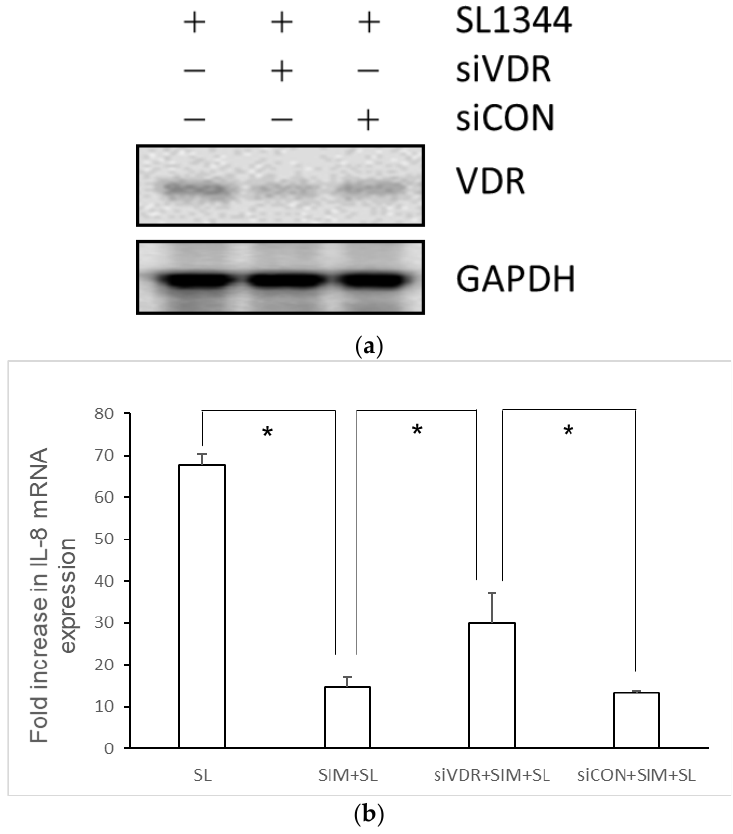
Figure 4. Involvement of vitamin D receptor (VDR) in simvastatin-mediated downregulation of IL-8 mRNA expression in Salmonella -infected SW480 cells. SW480 cells were transfected with control siRNA or VDR siRNA (siCON = non-target control siRNA; siVDR = siRNA against VDR) for 48 h. Transfected SW480 cells were treated with 10 μM simvastatin (SIM) prior to wild-type S. Typhimurium strain SL1344 infection (SL) for one hour. Knockdown of VDR was demonstrated by western blotting ( a ). Total RNA was extracted and analyzed by real-time quantitative PCR to estimate the levels of IL-8 mRNA ( b ). The amount of IL-8 mRNA produced, normalized to the corresponding amount of GAPDH mRNA, is shown as the fold increase over uninfected control (CON) cells. The results indicate the means and standard deviations for duplicate wells from at least three separate experiments (* p < 0.05).